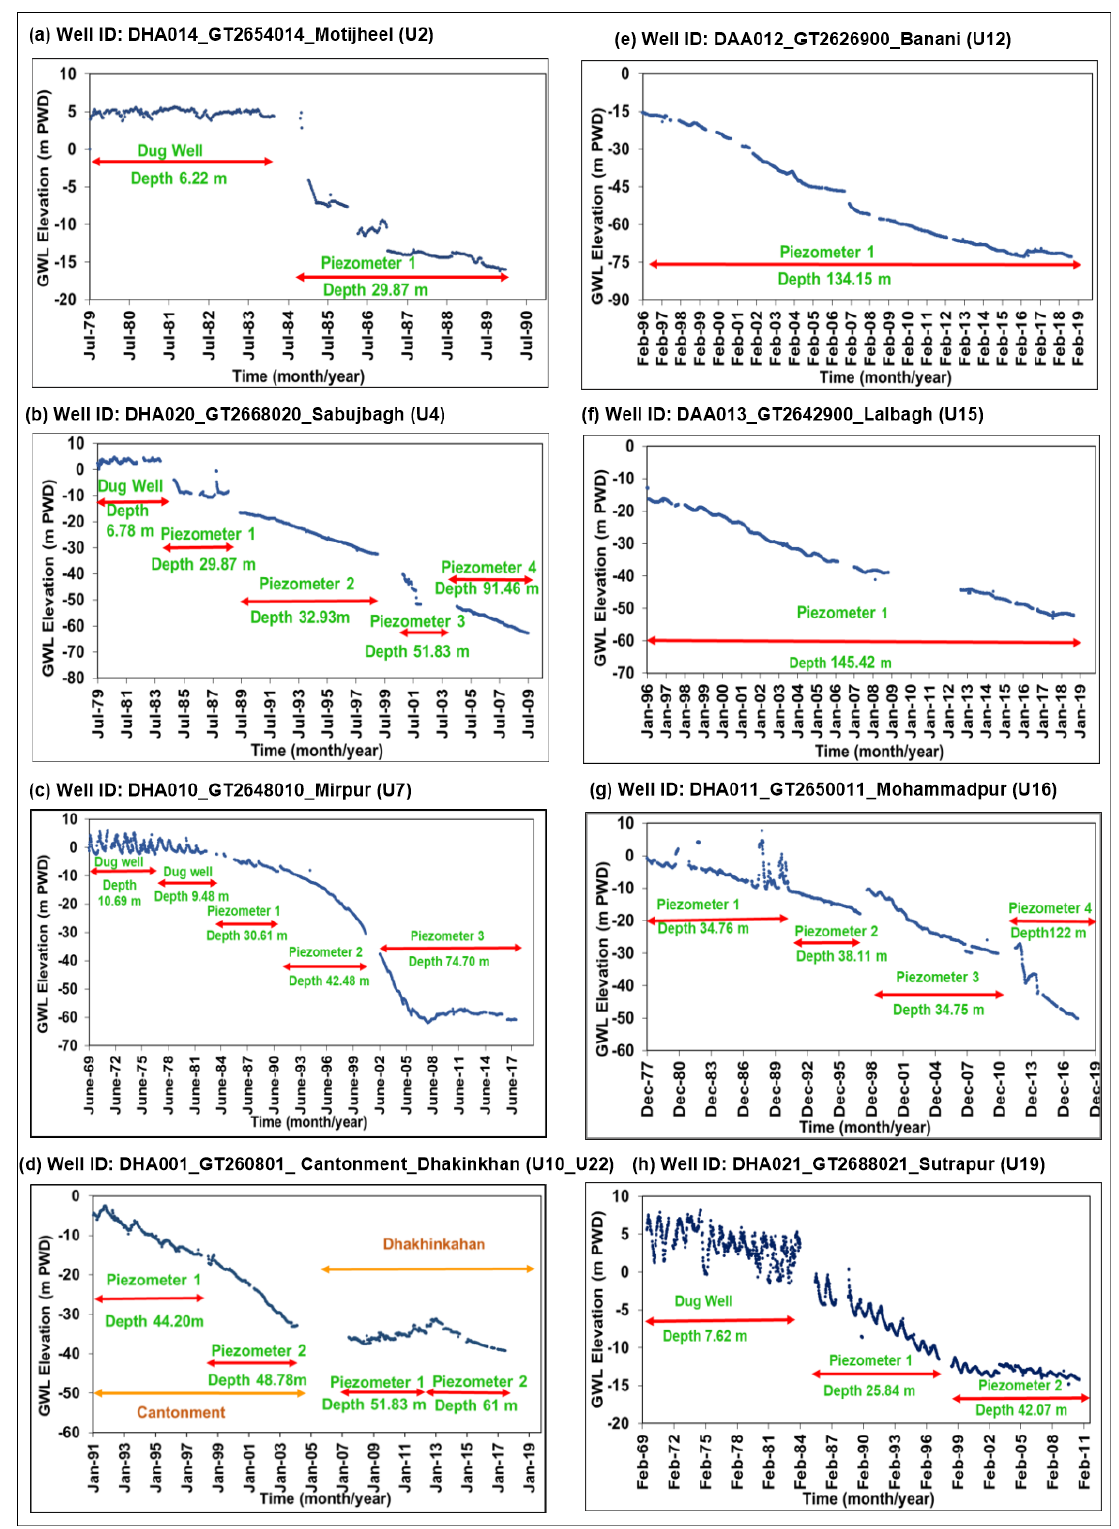
Figure 8. Long-term hydrographs of observation wells in Dhaka city. Note: GWL indicates a dug well and PL indicates a piezometric well in UDA. ( a ) Well ID: DHA014_GT2654014_Motijheel (U2), ( b ) Well ID: DHA020_GT2668020_Sabujbagh